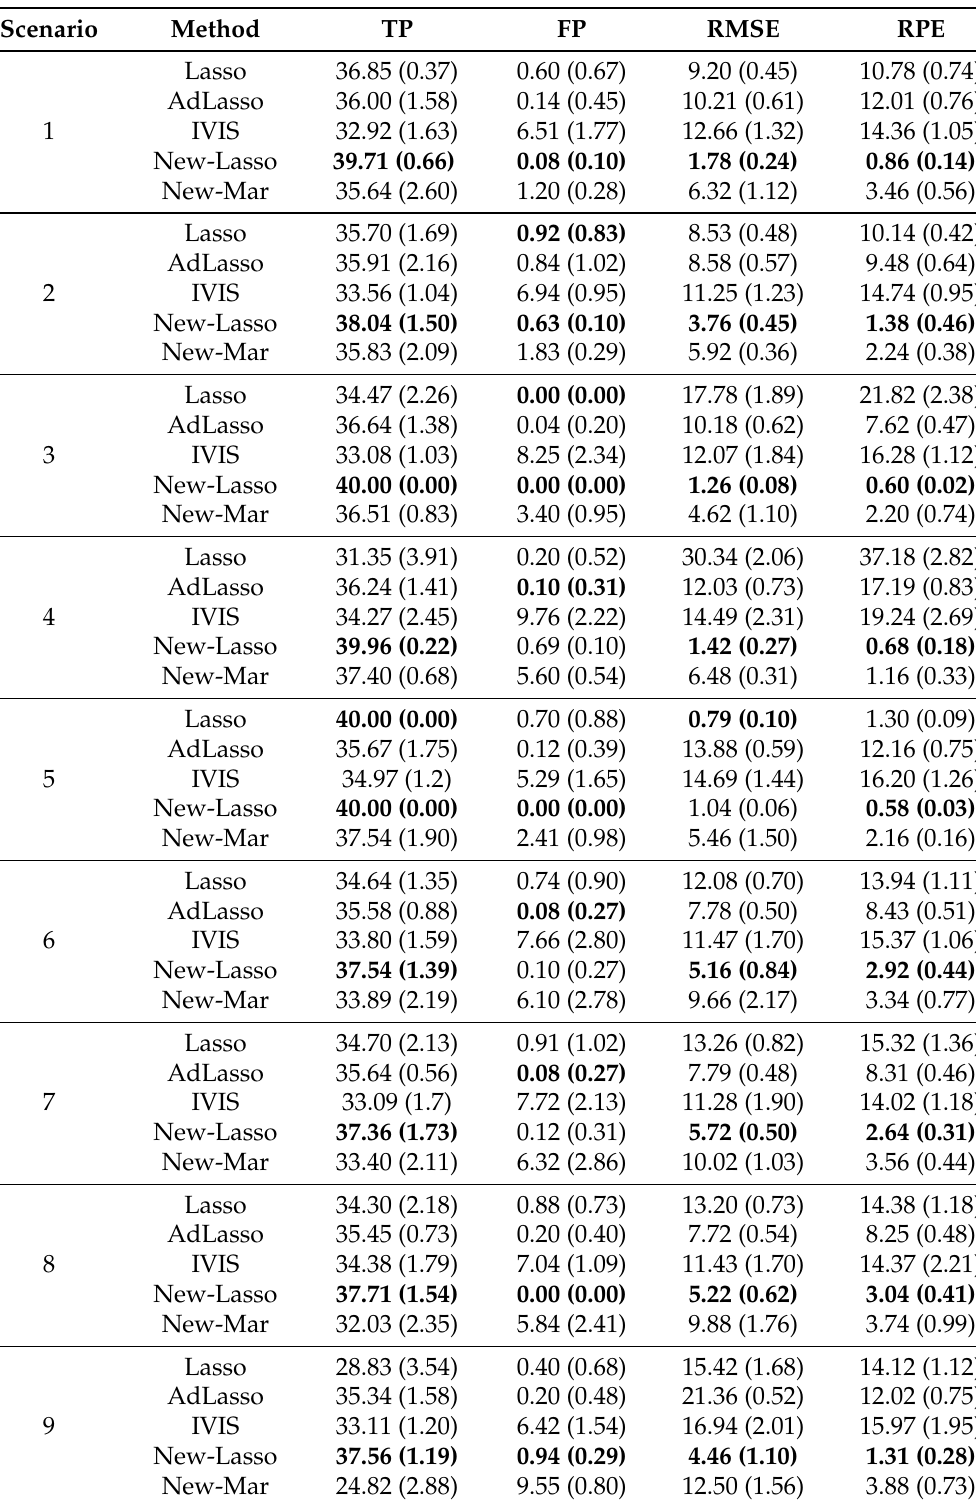
Table A2. Simulation results for N = 500, p = 500, q = 40, and ρ = 0.3. Each cell shows the mean (sd). The bold represents the best